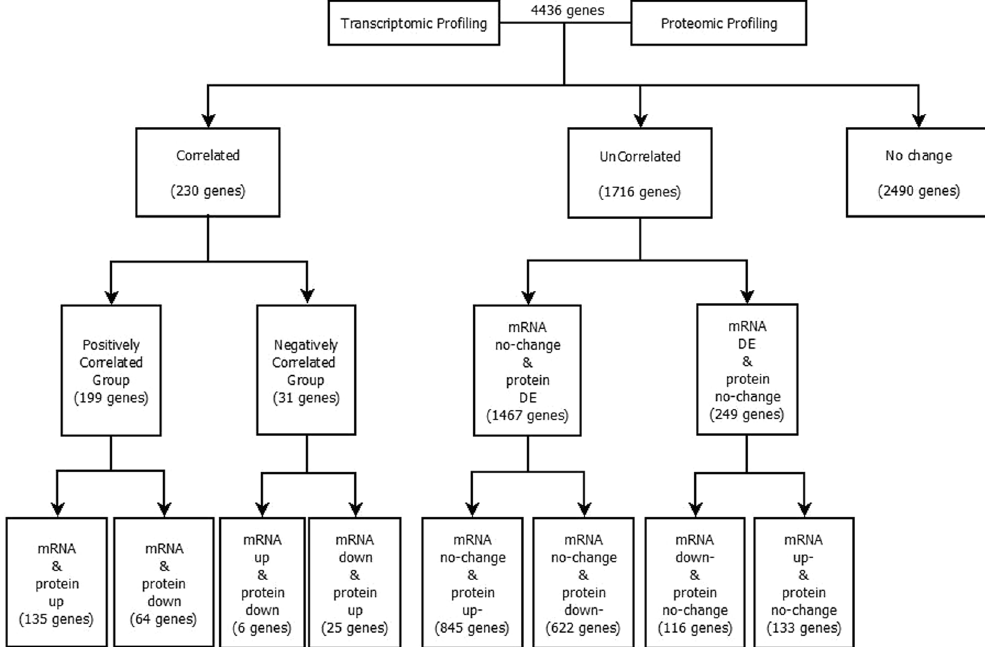
Figure 2. Diagram representing the classification of the integrated transcriptomic and proteomic datasets. Step 1: Integration of transcriptomic and proteomic profiling based on gene symbol matching. Step 2: Classification of differentially expressed genes into groups based upon changes in their respective mRNA and protein levels in OV and OM samples.